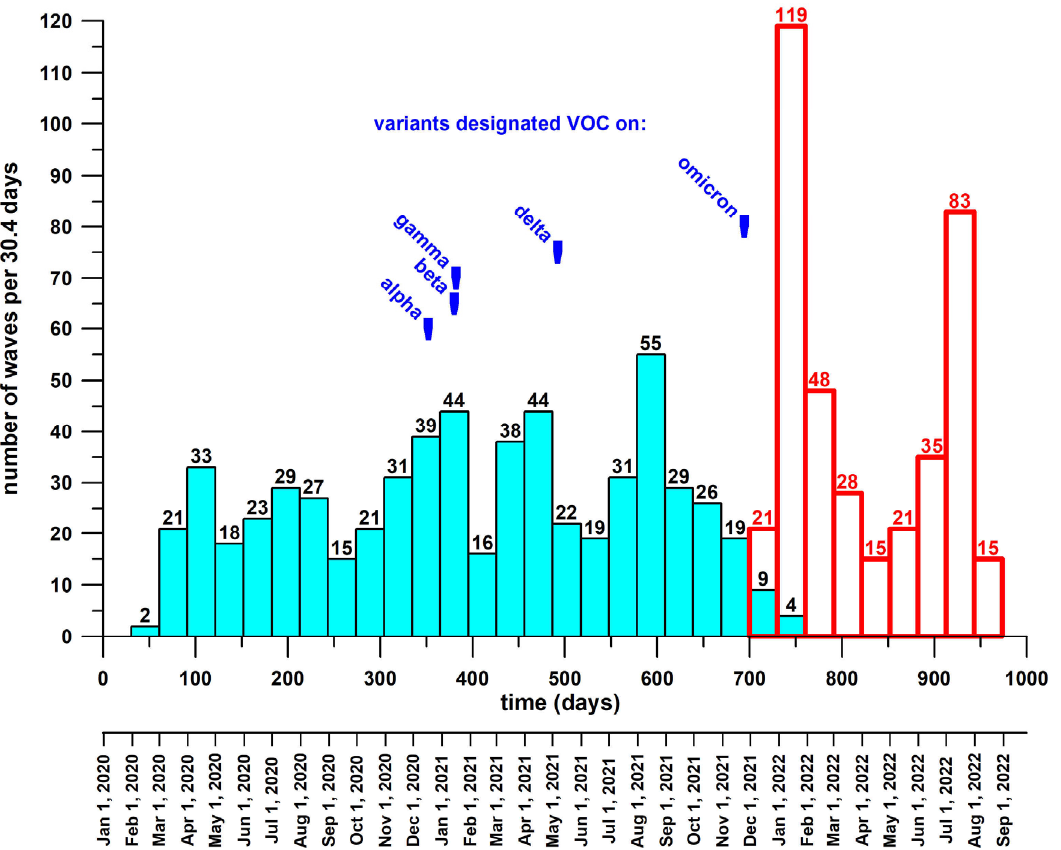
Figure 4. Wave histogram (density diagram): number of waves per month against the time (in days; day 1 = 1 January 2020); bin width = number of days of the mean year divided by 12.